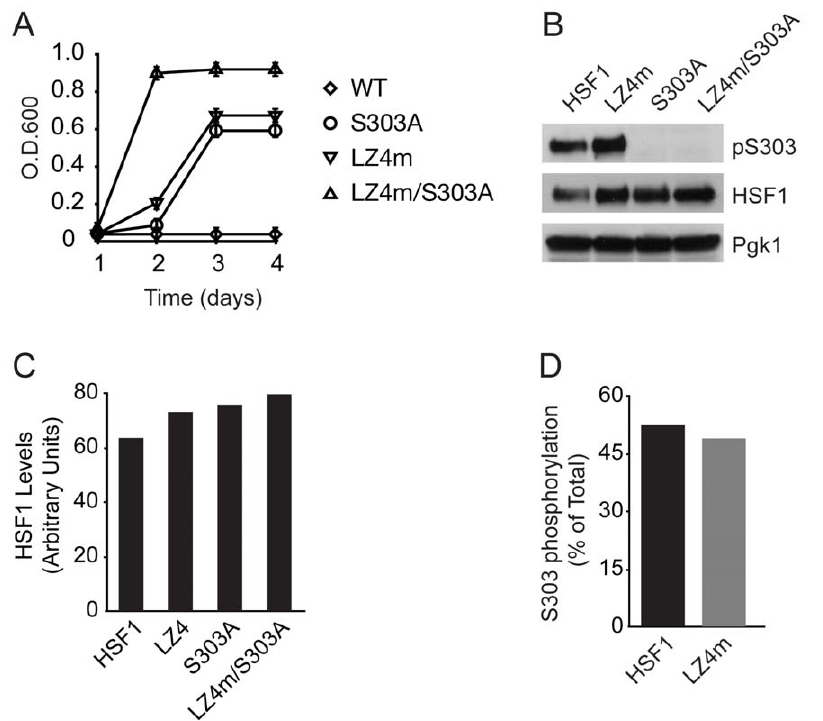
Figure 3. Phosphorylation of S303 and coiled-coil domains synergize in the repression of HSF1 in yeast. ( A ) PS145 expressing either wild-type HSF1 or mutant alleles of HSF1 were grown in dextrose supplemented medium for 4 d. Growth was monitored by measuring O.D. 600 . ( B ) PS145 was transformed with a plasmid expressing wild-type HSF1 (WT) or mutant alleles of HSF1 and grown on galactose containing medium. Total protein extracts were analyzed for pS303, total HSF1 and Pgk1 by immunoblotting. ( C ) Protein levels of HSF1 were normalized to Pgk1, from panel B. ( D ) Levels of HSF1 phosphorylated at S303 were quantified and are shown as a percent of total HSF1, from panel B.